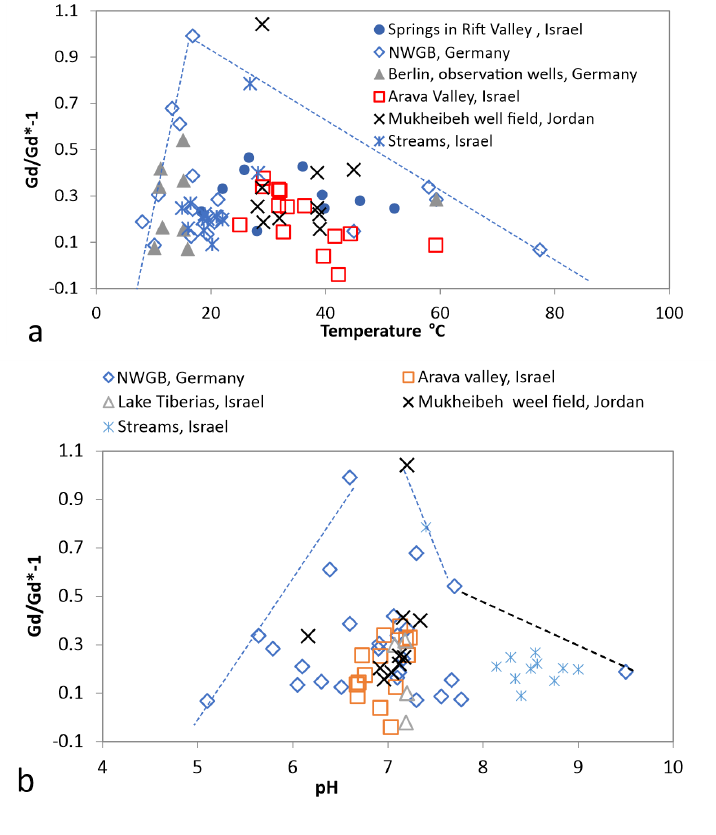
Figure 12. Cross plots of Gd anomalies of groundwater and temperature ( a ) and pH ( b ) showing that the Gd anomalies vanish with both increasing pH and temperature. The dashed lines are bordering